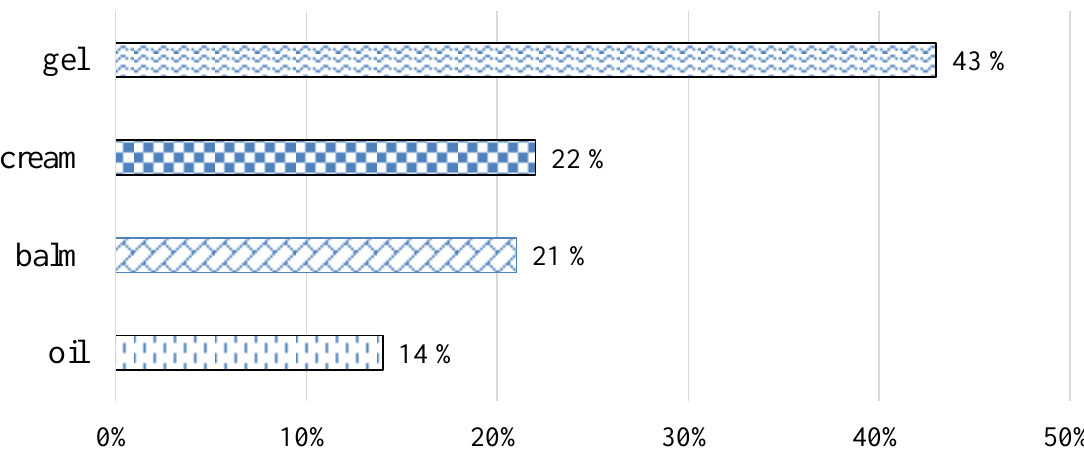
Fig. 1. Ranking of AKPF for dosage